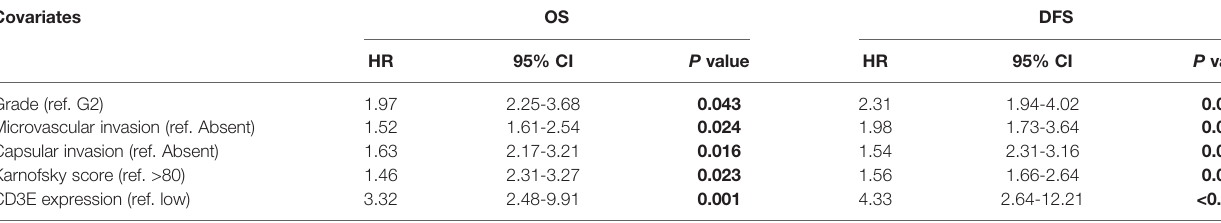
TABLE 2 | Multivariate Cox regression analysis of DFS and OS in AHYMUM cohorts. Covariates OS DFS HR 95% CI Grade (ref. G2)